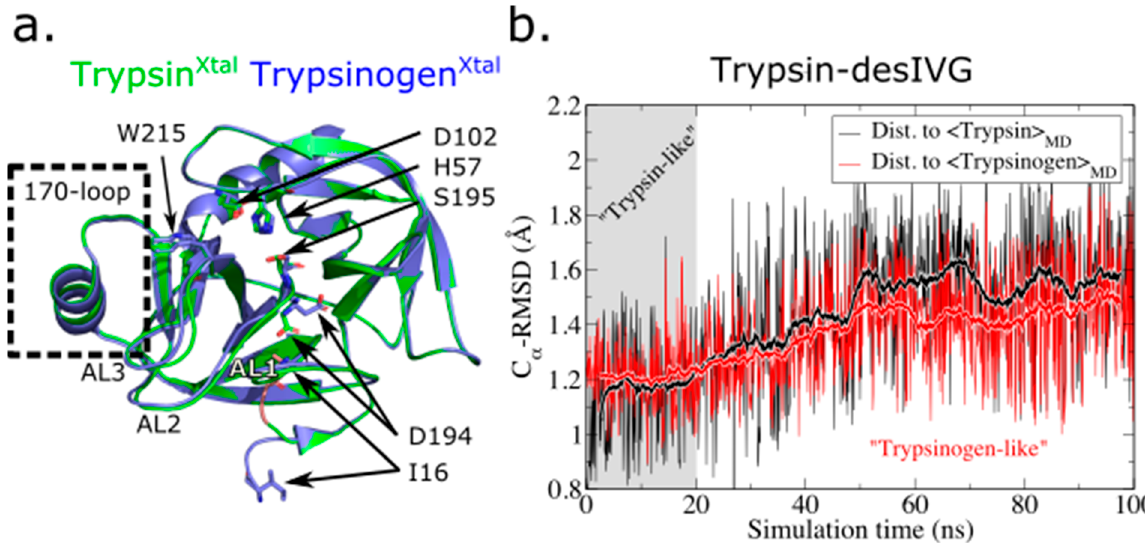
Figure 1. ( a ) Structural comparison of the trypsin and trypsinogen crystal structures. Select amino acid residues and spatial regions of special interest are labeled. Structure PDB IDs are indicated in Table 1. ( b ) The alpha-Carbon root-mean-squared deviation ( C α -Root-mean-squared deviation (RMSD)) from the simulated average structures of trypsin (<Trypsin> MD ) and trypsinogen (<Trypsinogen> MD ) is plotted for the trypsin-desIVG trajectory. The thicker lines with white edges indicate the running-average value over 50 steps.